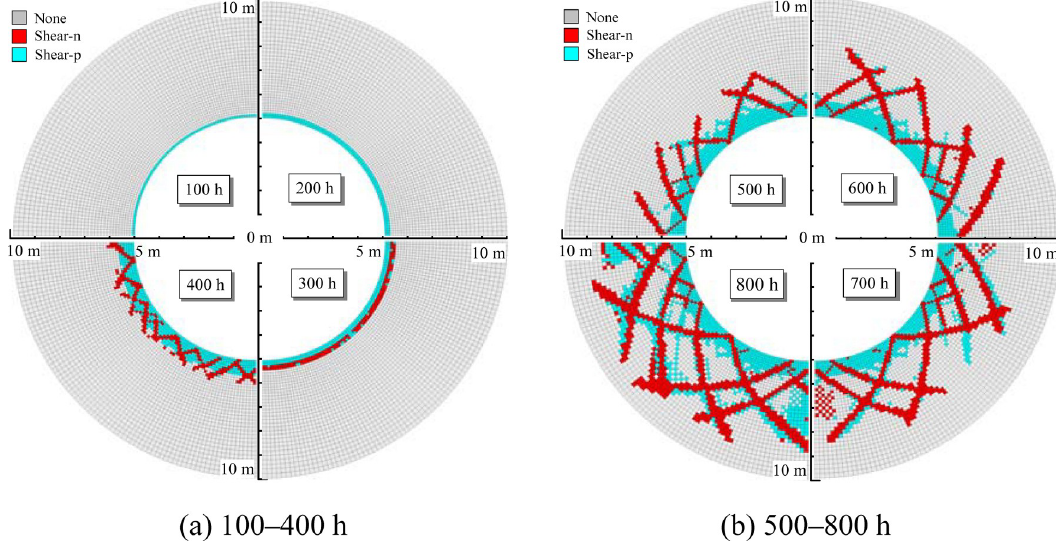
Fig 14. Evolution law of the plastic zone of rock surrounding a tunnel (NBSS model). (a) 100–400 h (b) 500–800 h.